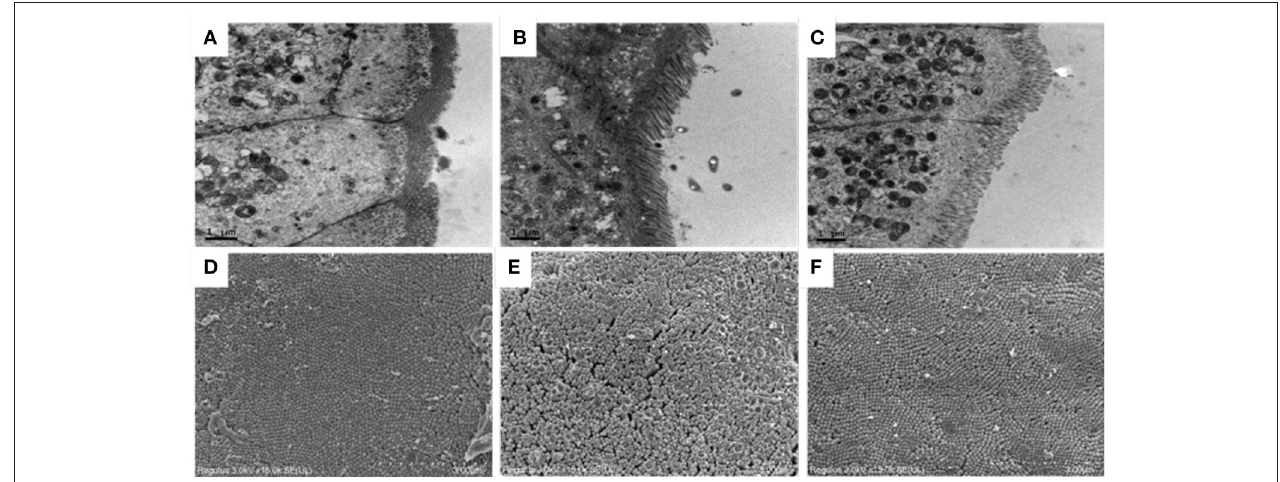
FIGURE 3 | Effects of OP on ileum villi morphology in immunosuppressed mice. (A–C) Transmission electron microscopy, 10K × , (A) : Normal group, (B) : Cy-induced group, (C) : Cy + 400 mg/kg OP, (D–F) : Scanning electron microscopy, 15K × , (D) : Normal group, (E) : Cy-induced group, and (F) : Cy + 400 mg/kg OP.